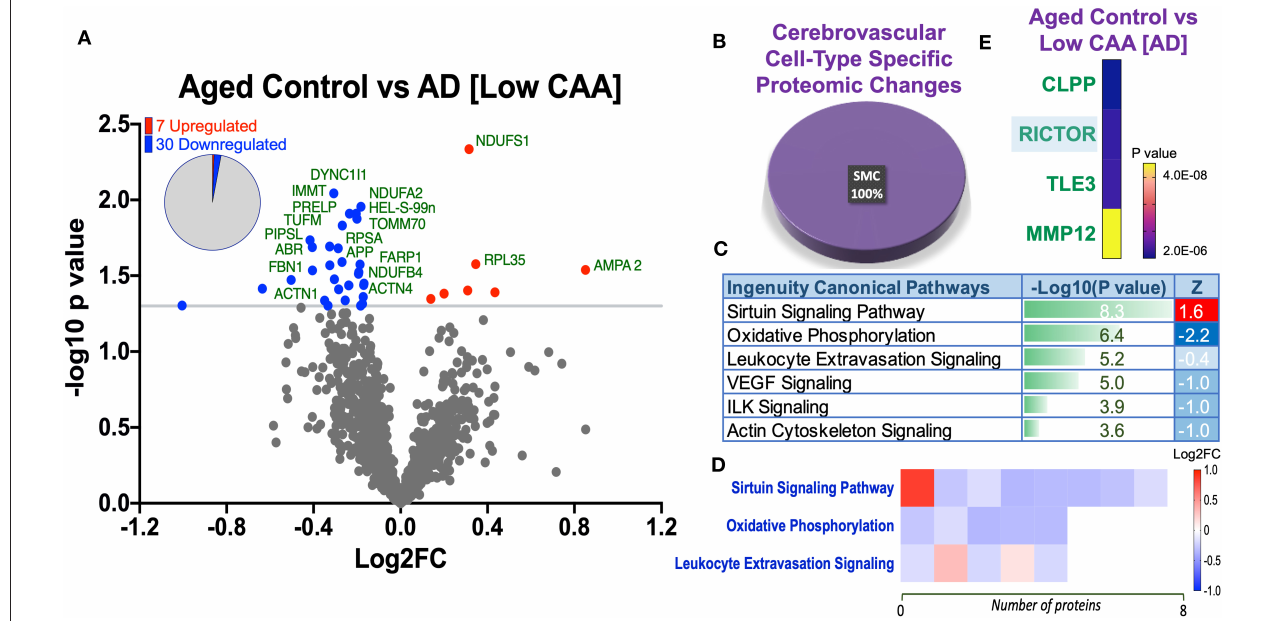
FIGURE 5 | Proteomic changes, cell origin, signaling pathways, upstream regulator factors observed from the cerebrovasculature isolated from the inferior frontal gyrus of low CAA vs. aged-matched control cases. (A) Volcano plot of differentially expressed proteins in low CAA vs. aged-matched control cases (pie chart inset shows up/down-regulated proteins, significant cut off set at 1.3 and red and blue points indicated up- or down-regulated significant proteins, respectively). (B) Pie Chart show origin of cell types where significant proteins from the comparisons between low CAA vs. aged-matched control cases are observed. Data are generated from the number of significantly regulated proteins per specific cell type (from the PanglaoDB omic database), expressed as a percentage. (C) Canonical pathways identified from ingenuity pathway analyses [data depict –log10 [ P -value] and Z score generated from Fischer test of an overlap with the IPA knowledgebase; blue—downregulated and red—upregulated], and (D) shows heat map of the top 3 pathways and the corresponding number of significantly regulated proteins altered per pathway and their Log2 fold change expression level. (E) Shows Top 4 identified upstream regulators from the ingenuity pathway analyses of differentially regulated proteins in low CAA vs. aged-matched control cases ( light blue highlighted text indicates that the upstream regulator is predicted to be activated